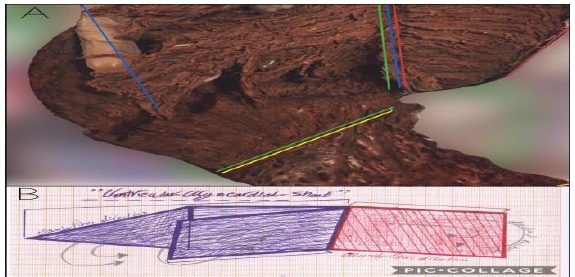
Figure 11. A, VMS-segments in cow heart. Showing the subendocardial segment between red lines, mesocardial segment between blue lines, proximal part of subepicardial segment between green lines and